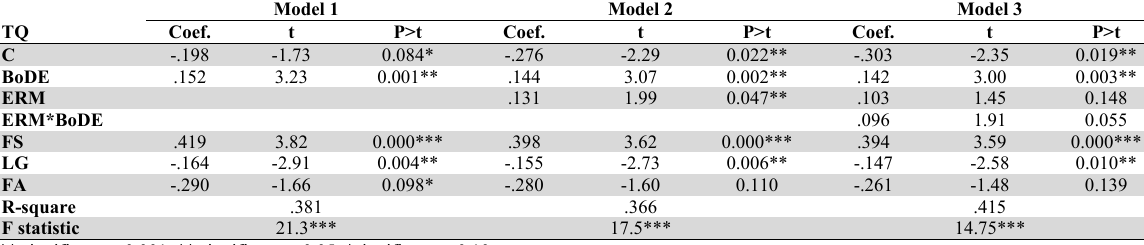
The result of the moderating effect of ERM between BoDE and TQ Model